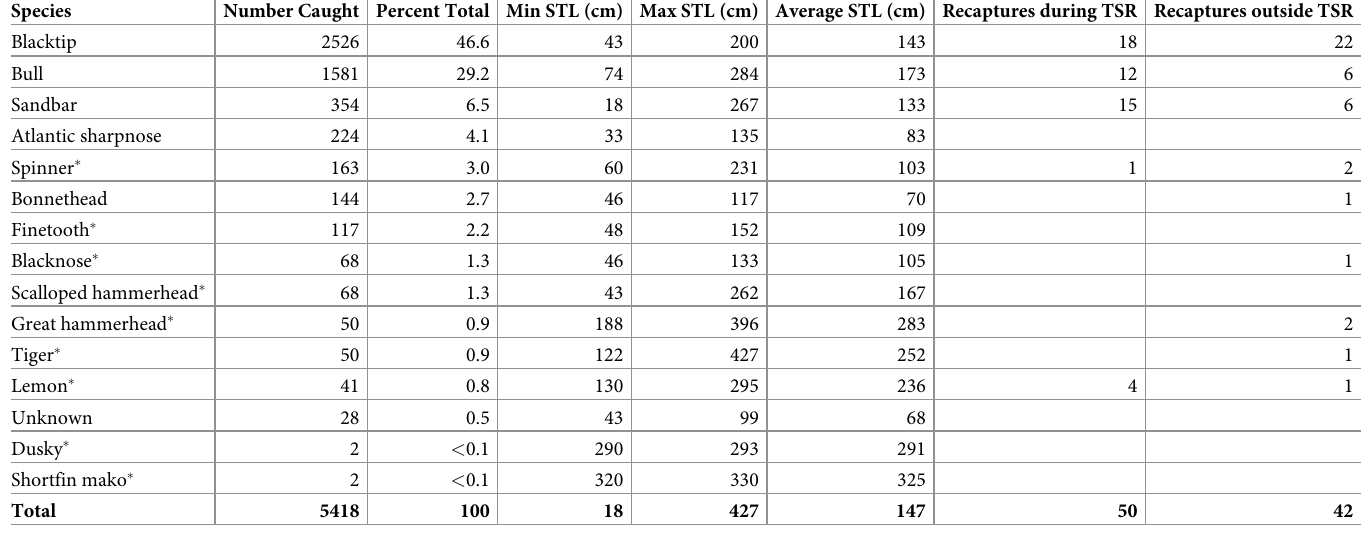
� uncommon species designation under TSR